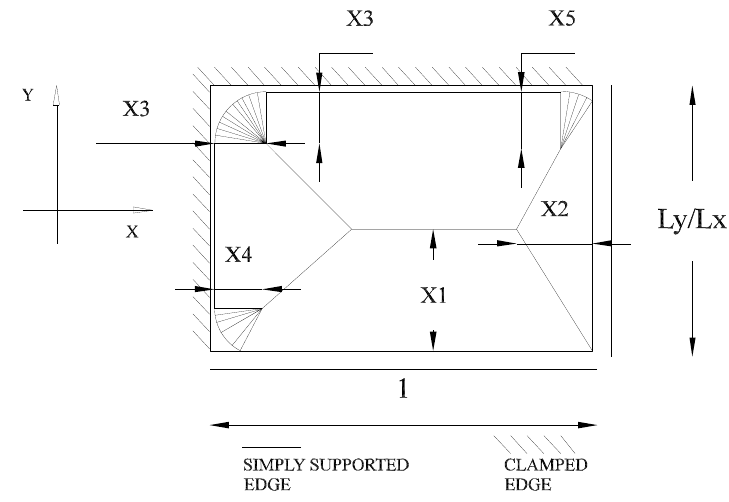
Figure 3. Slab geometry and mechanism parameters.